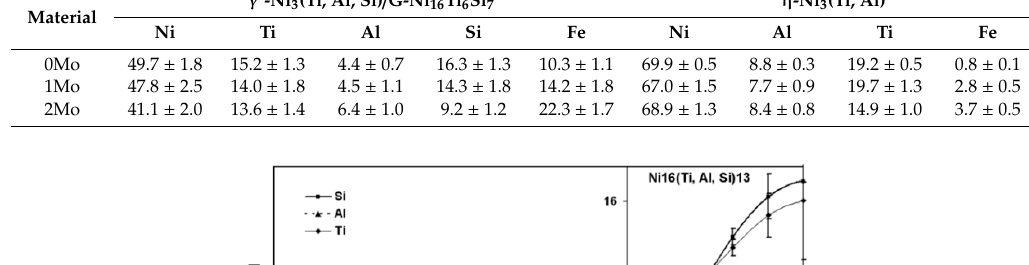
Figure 5. Proxigram obtained from Si-containing Ni-rich precipitates (G-phase) in 0Mo aged for 40 h at 475 °C showing rejection of Al. Table 3. Composition of the two types of Ni-rich precipitates after aging for 40 h at 475 °C (at.%). Material